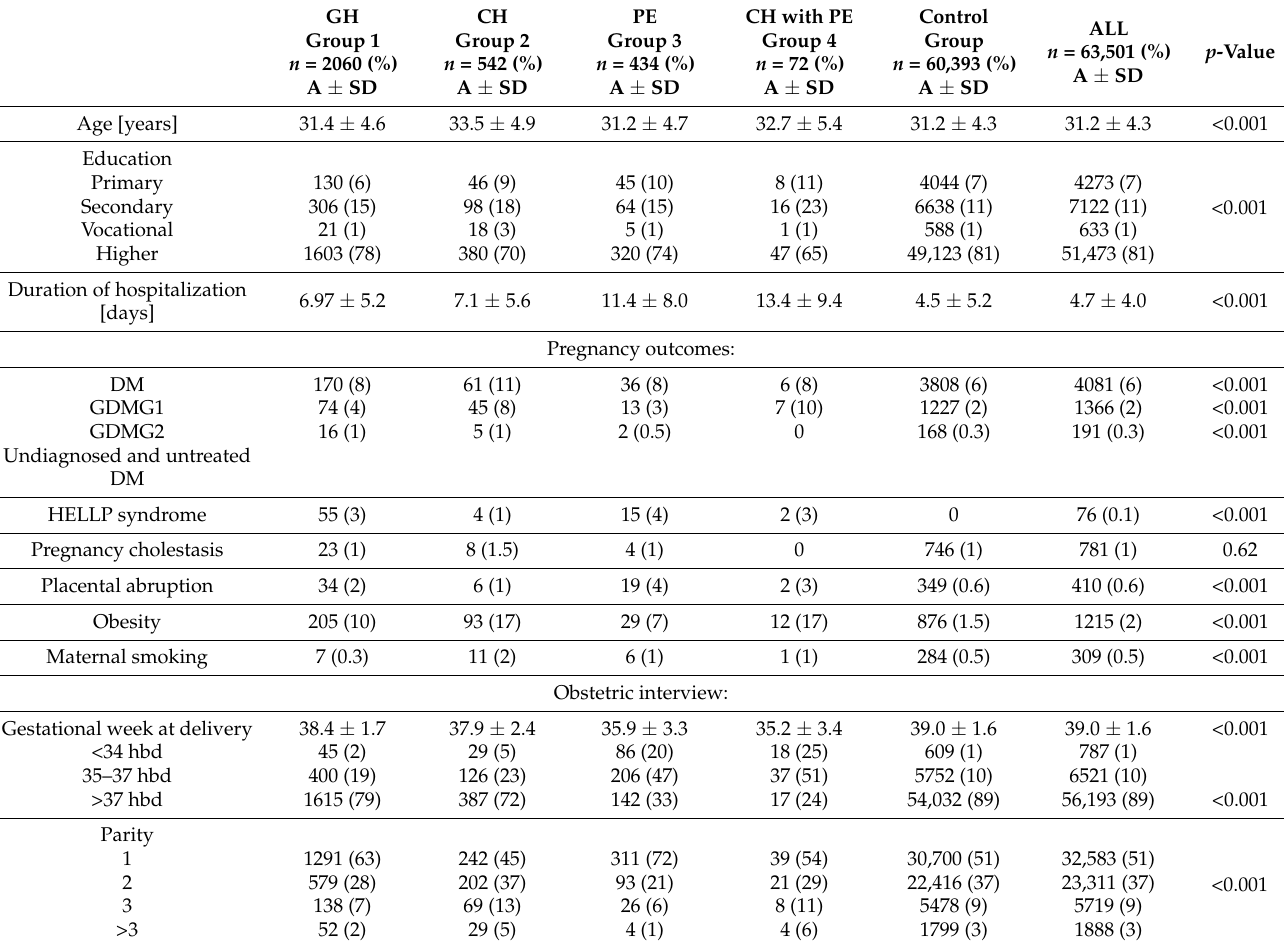
Table 2. Characteristics of the